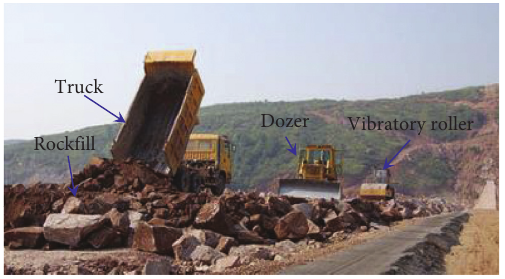
Figure 1: Vibratory roller compaction of field